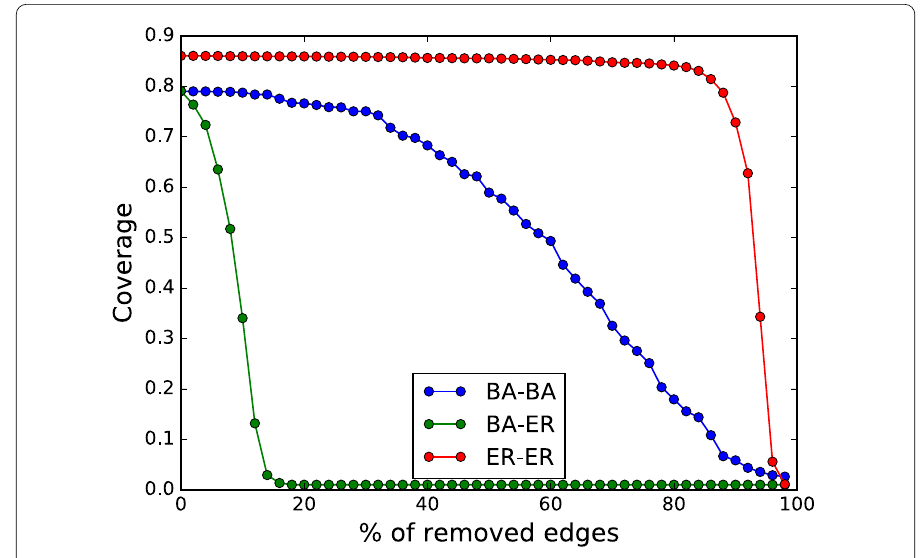
Figure 6 Robustness of random multiplexes to random failures. The curves are averaged over three independent runs